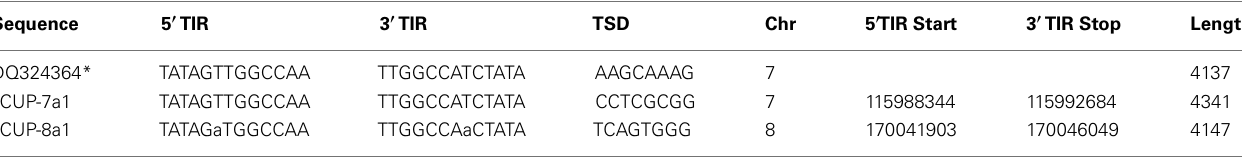
Table 1 | Summary of autonomous TCUP elements in the maize genome